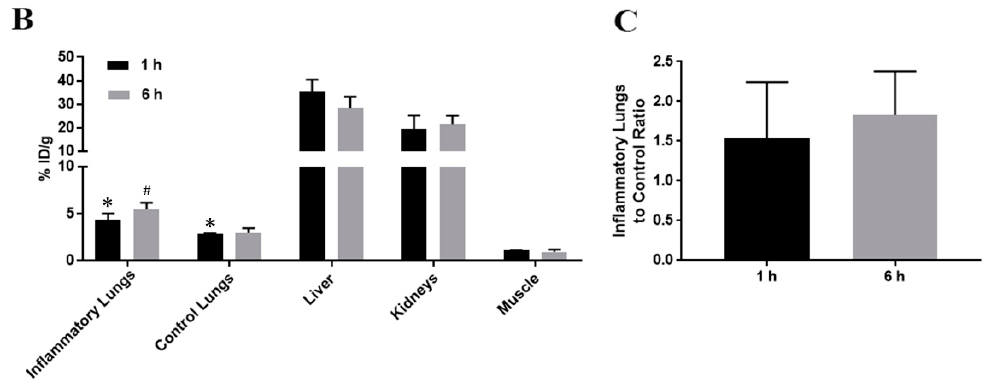
Figure 2. ( A ) Decay-corrected whole-body coronal small animal PET images of animal models of LPS induced lung inflammation at 1 h and 6 h after intravenous injection of 64 CuCl 2 , respectively (The inflammatory lungs are indicated by arrows); ( B ) Small animal PET quantification analysis of inflammatory lungs, control lungs and major organs (liver, kidney and muscle) at 1 h and 6 h post-injection of radioactive copper, respectively ( n = 4) (* p = 0.027, # p = 0.009); ( C ) Small animal PET quantification analysis of ratio of inflammatory lungs to control lungs at 1 h and 6 h post-injection of radioactive copper, respectively ( n = 4).